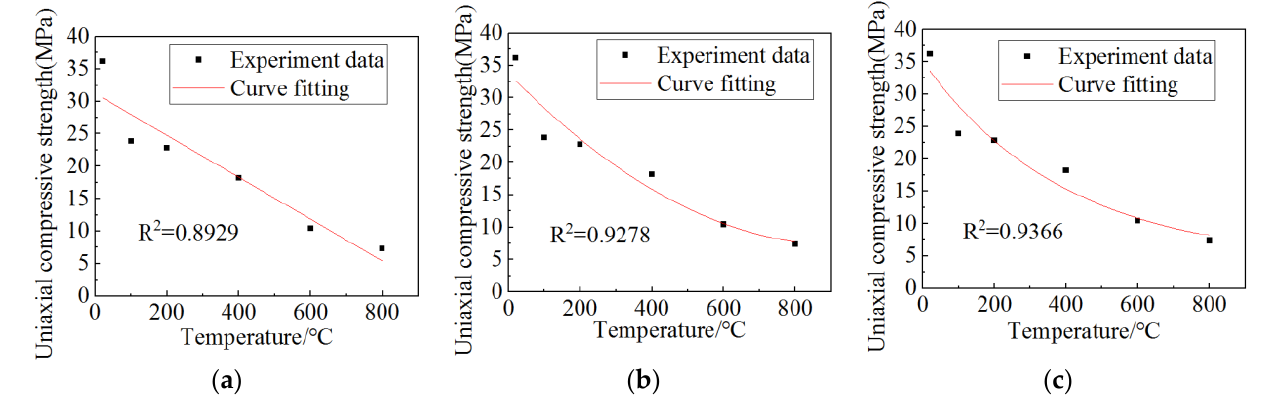
Figure 6. Fitting curve of the relationship between uniaxial compressive strength and temperature: ( a ) linear fitting; ( b ) polynomial fitting; ( c ) exponential fitting.